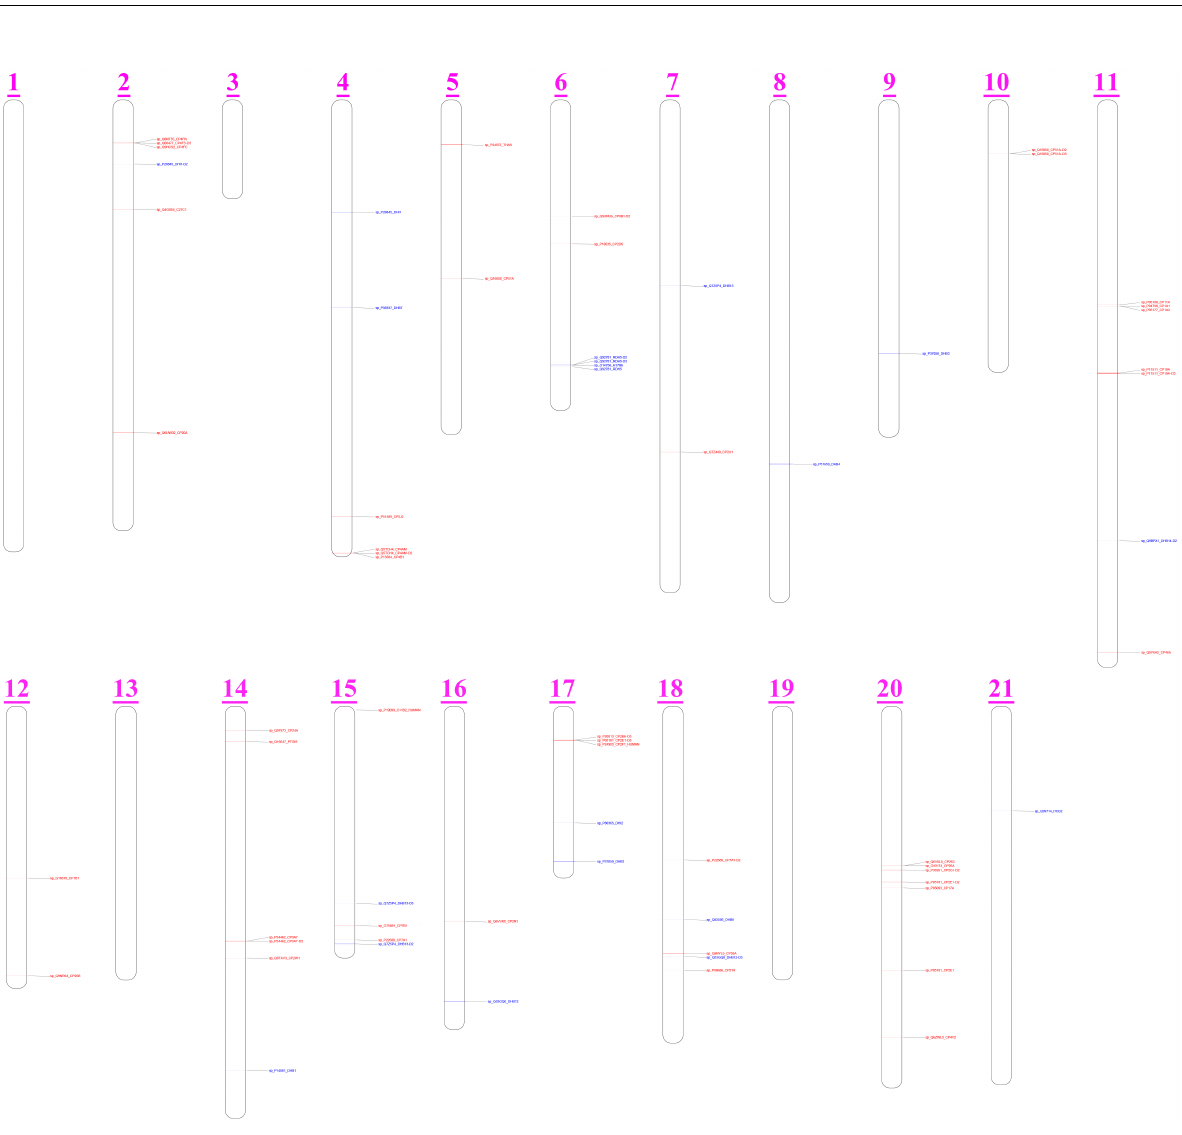
Figure 7. Chromosomal distribution of the functional HSDs and CYPs of the sperm